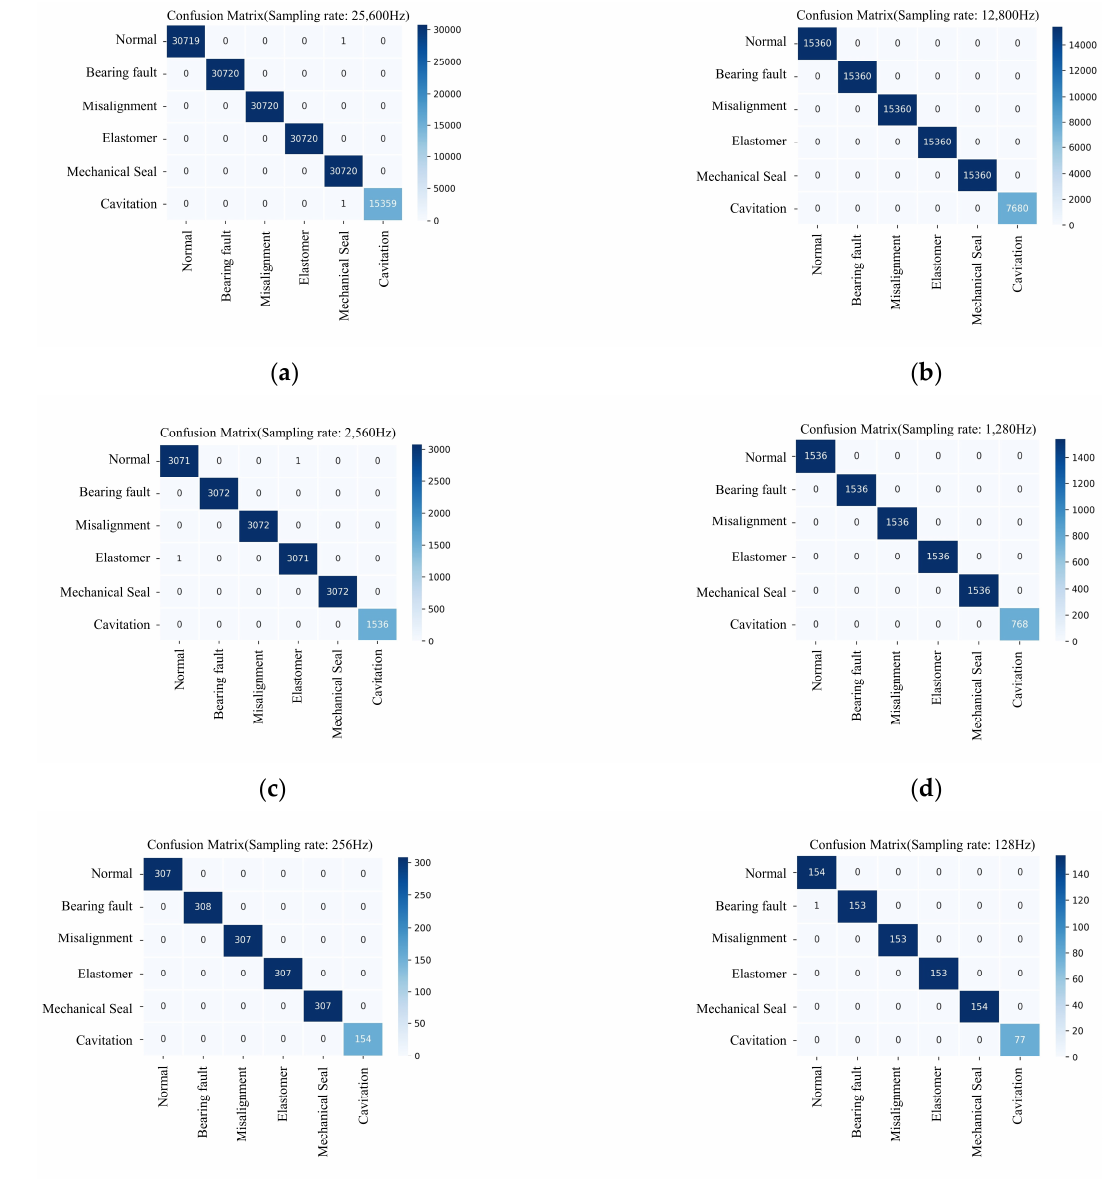
Figure 7. Multi-class confusion matrix as the results of the fault classification by sampling rate: ( a ) 25,600 Hz; ( b ) 12,800 Hz; ( c ) 2560 Hz; ( d ) 1280 Hz; ( e ) 256 Hz; and ( f ) 128 Hz.